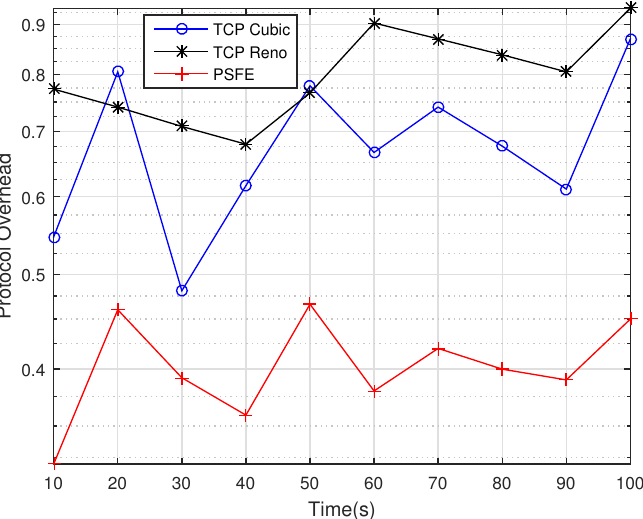
Figure 9. Comparisons of protocol overhead for packet-forwarding